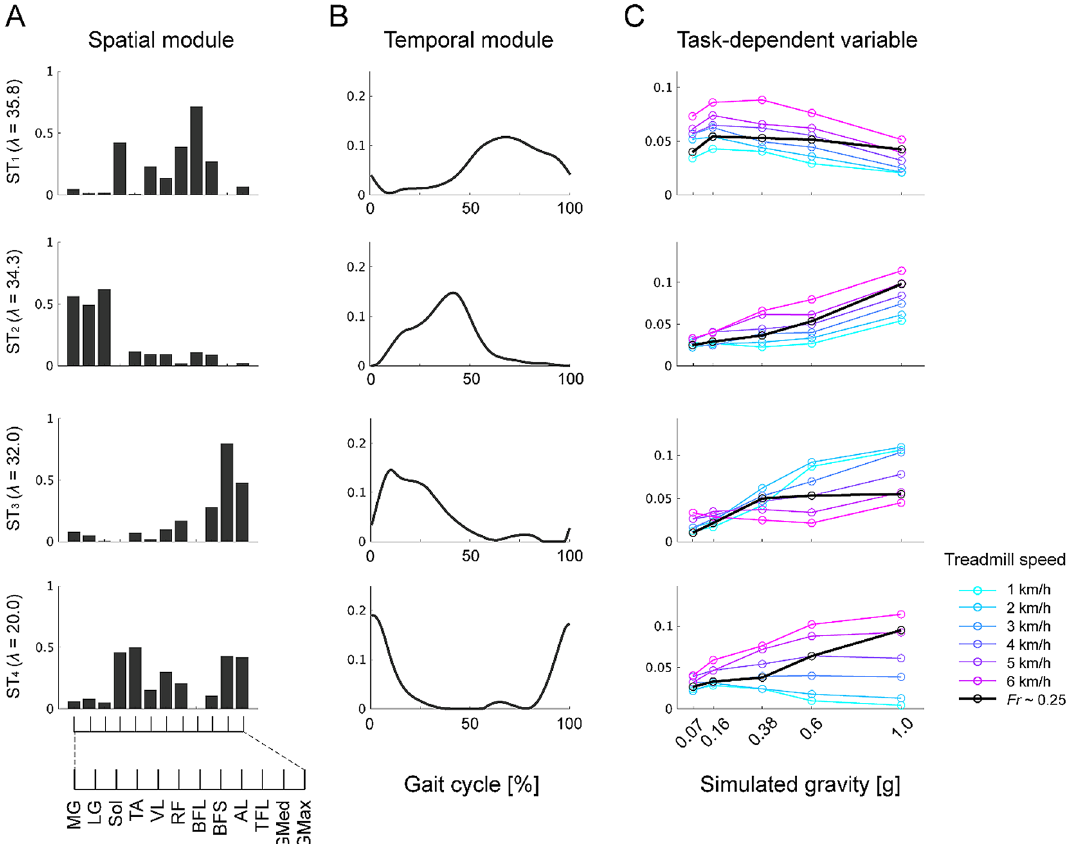
Figure 9. Spatial and temporal modules and task-dependent variables across walking speeds. Spatial ( A ) and temporal ( B ) modules and corresponding task-dependent variables ( C ) extracted from the EMG data tensor at 7 walking speeds (1–6 km/h and a speed corresponding to Fr ~ 0.25) are shown. λ denotes the scaling factor. The circles and lines for the task-dependent variables in the individual treadmill speed are distinguished by